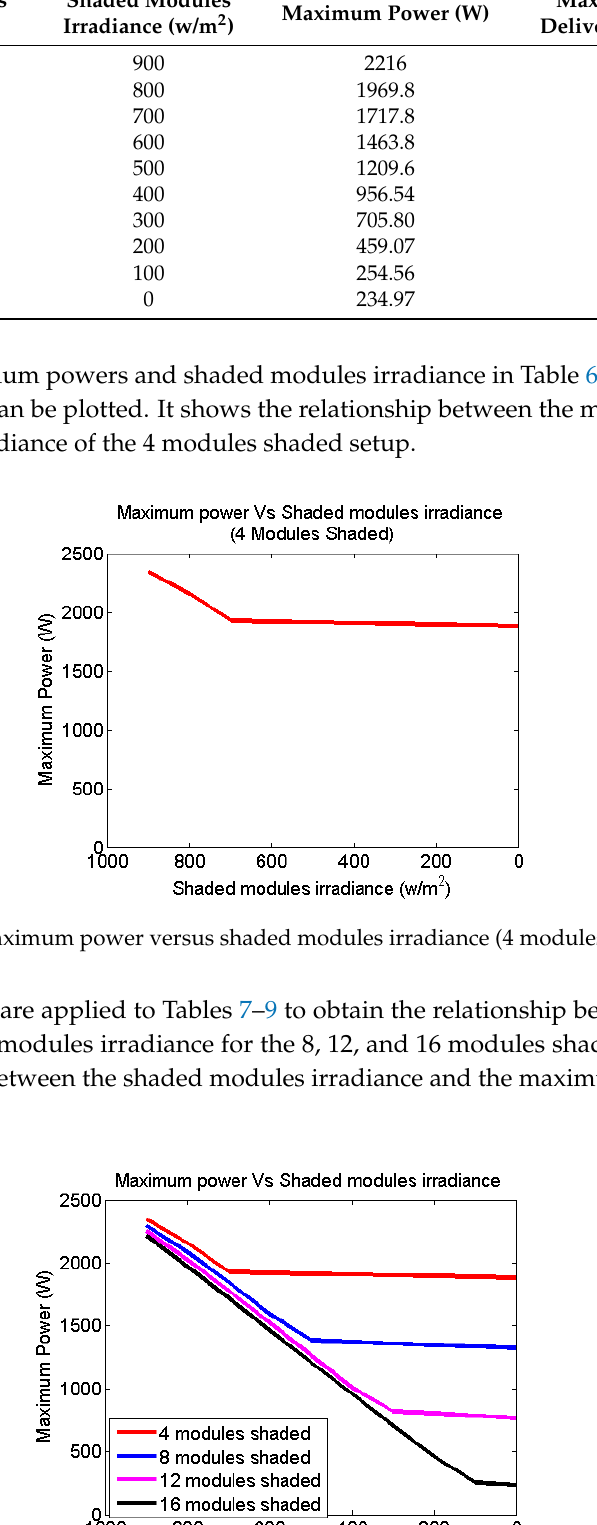
Table 9. Maximum powers of the 16 modules shaded setup.